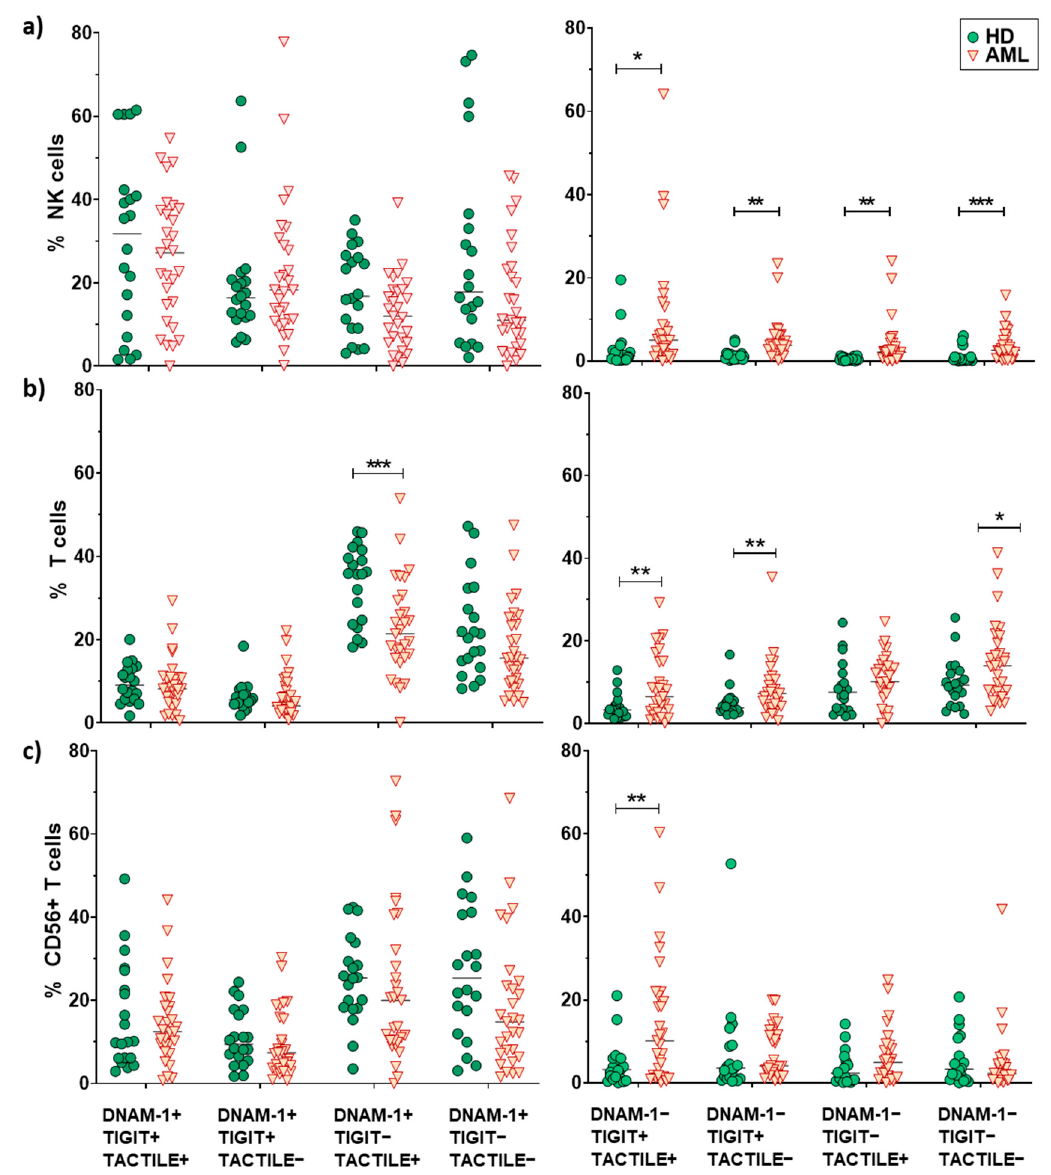
Figure 3. Analysis of DNAM-1, TIGIT and TACTILE co-expression. Eight different subpopulations can be observed according to the co-expression of DNAM-1, TIGIT and TACTILE. The distribution of these subsets in NK cells ( a ), CD56 − T cells ( b ) and CD56 + T cells ( c ) is shown. The median values are indicated by a horizontal black line. Results were considered significant at * p < 0.05 and ** p < 0.01 *** p < 0.001.